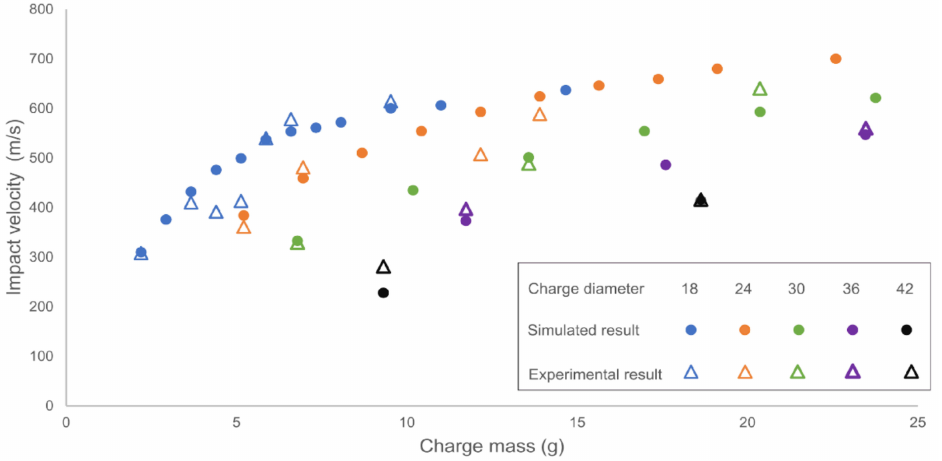
Figure 1. Graph of impact velocity versus charge mass, comparing experiments and simulations using data